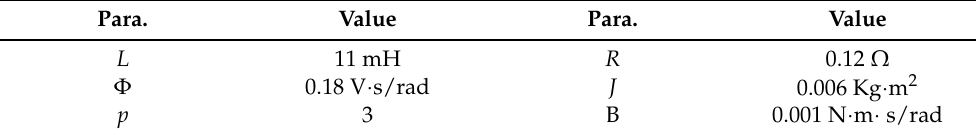
Table 1. PMSM Parameters.